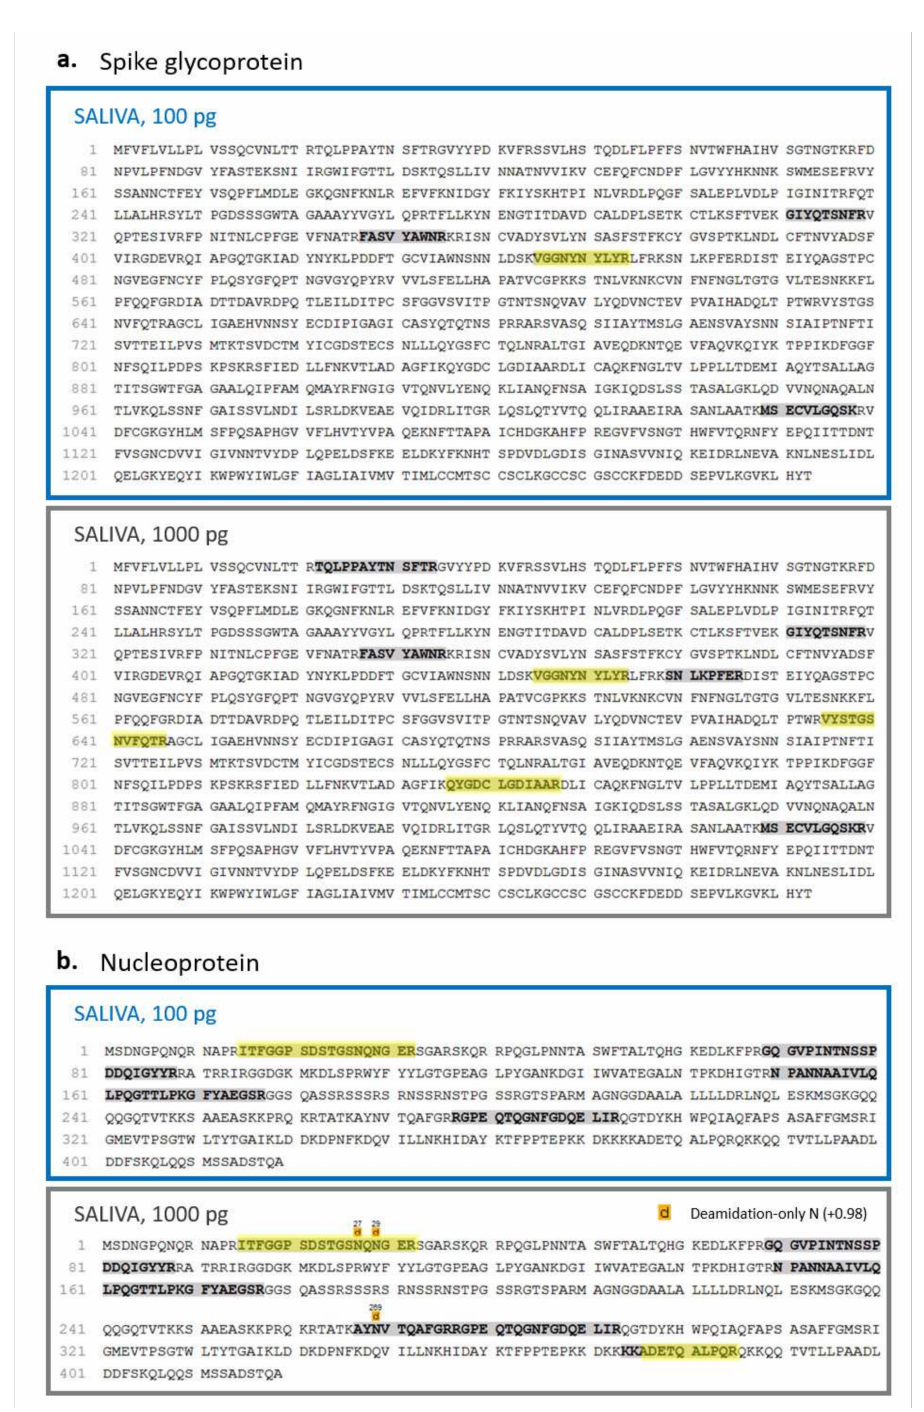
Figure 6. Sequence coverage of the spike glycoprotein and the nucleoprotein in saliva (post-digestion). Peptides identified for the spike glycoprotein ( a ) and the nucleoprotein ( b ) analysing 100 pg and 1000 pg of each purified SARS-CoV-2 protein (S1, S2, RBD and N) spiked into saliva after digestion. Possible sites of N-glycosylation are identified with letter d and the number of the AA sequence. The sequence covered is in bold and highlighted in grey or yellow; peptides highlighted in yellow are those also observed in the